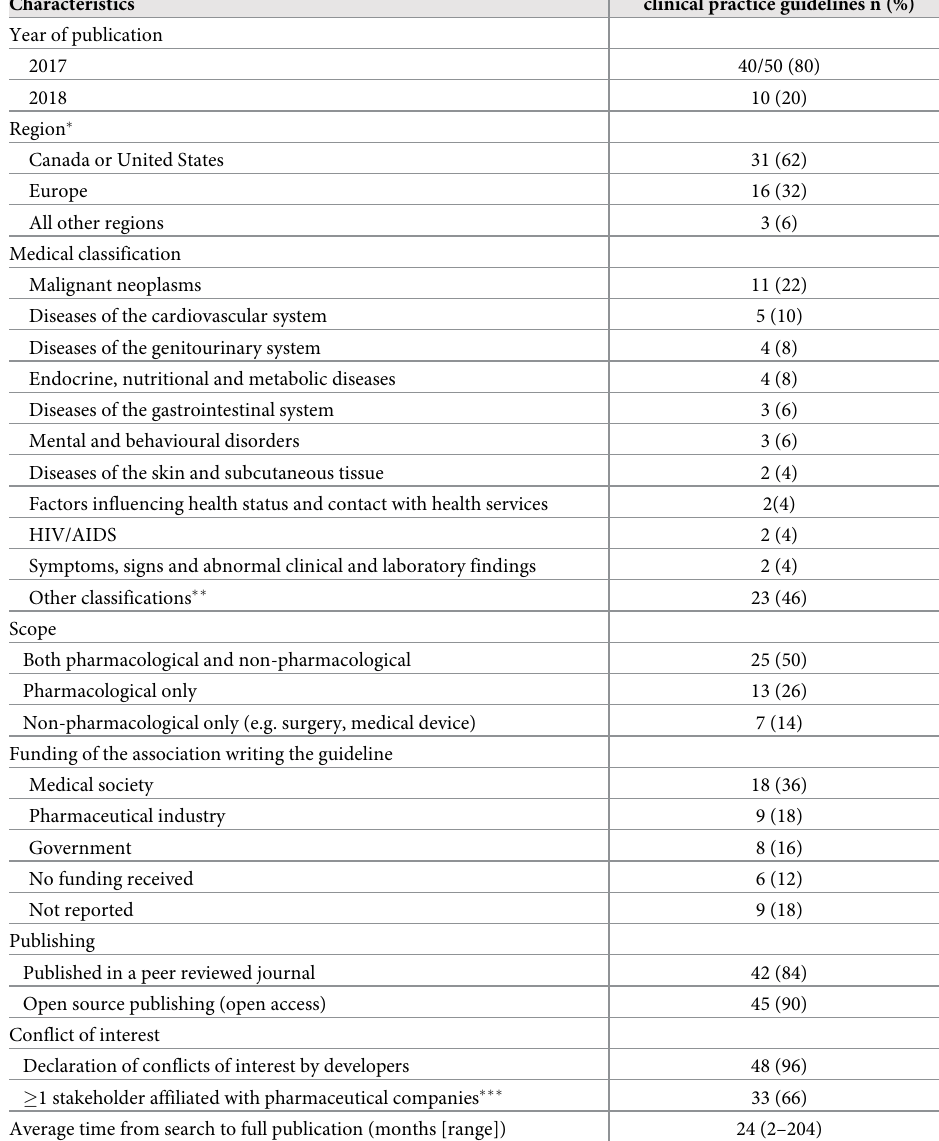
Table 2. Characteristics of clinical practice guidelines (n =